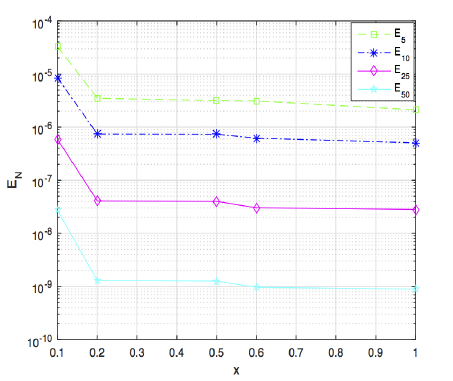
Figure 5. L ∞ convergence results at x = [0 , 1] for N = 5 , 10 , 25 , and